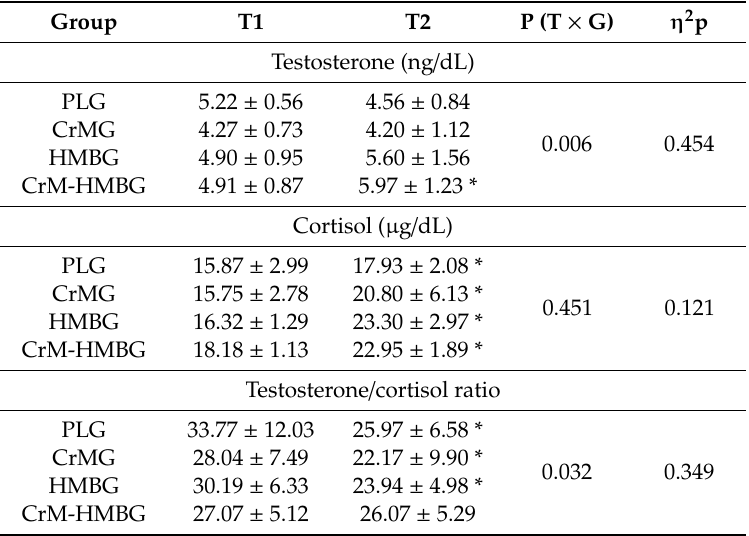
Table 3. Participant’s testosterone and cortisol hormone